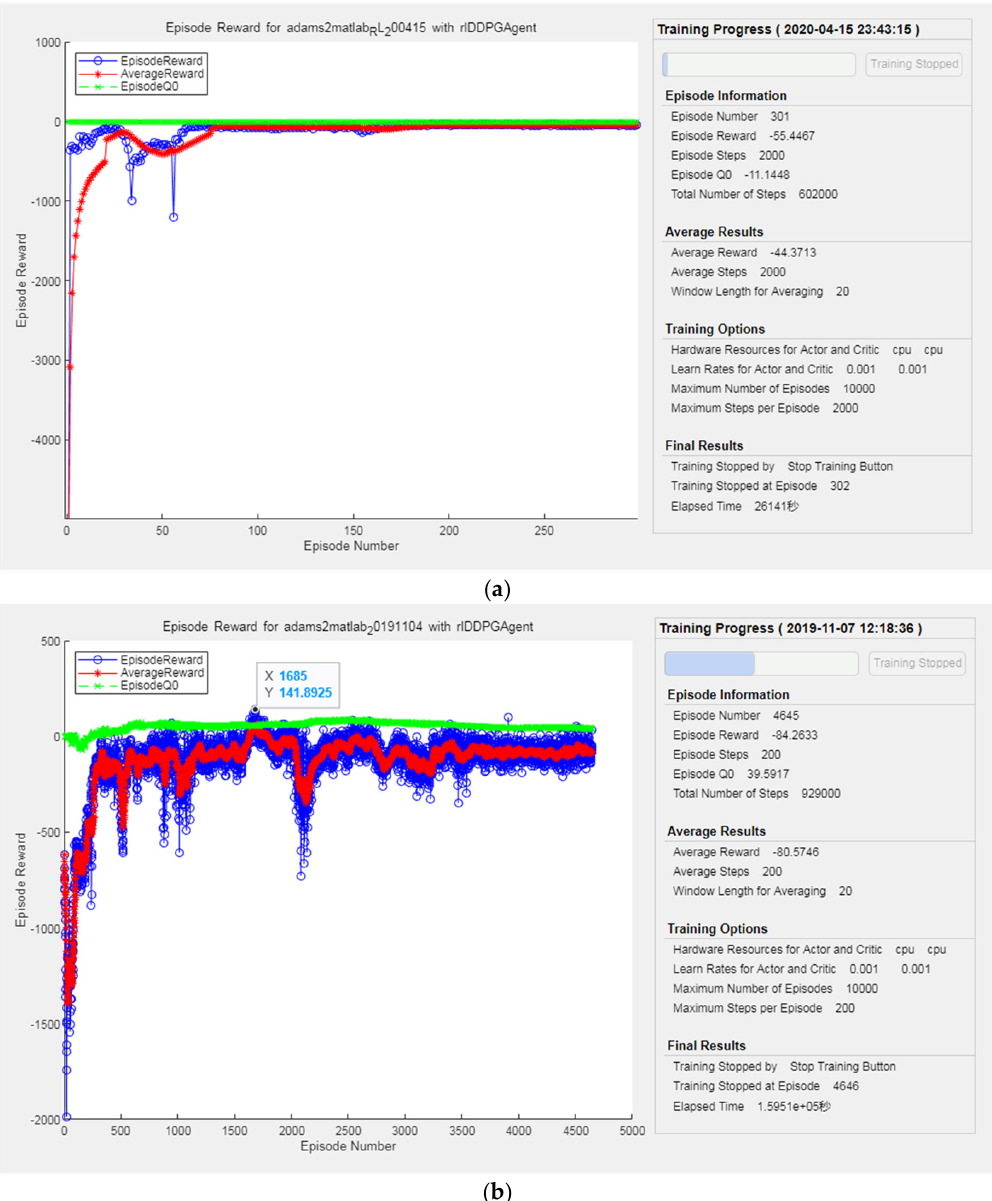
Figure 7. The learning process of episode reward in DDPG: ( a ) single parameter and ( b ) mul- ti-parameter.